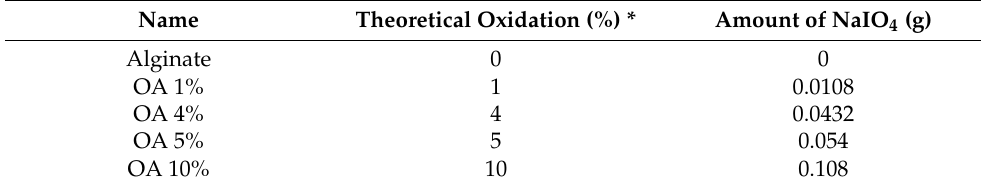
Table 1. Theoretical calculations for alginate